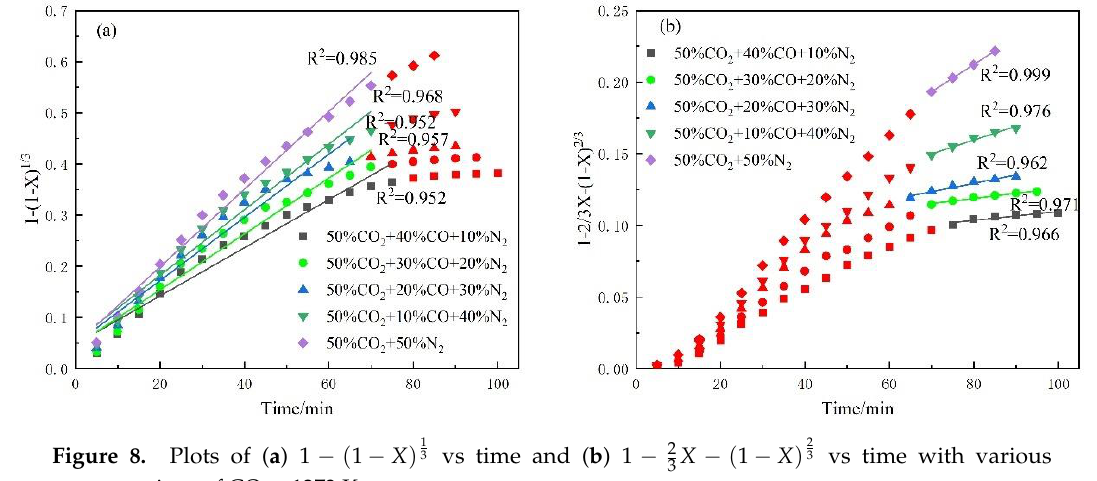
1 2 2 X − ( 1 − X ) 2 3 vs time with various 𝑋 − (1 − 𝑋) 3 vs time and ( b ) 1 − 3 vs time with various 3 3